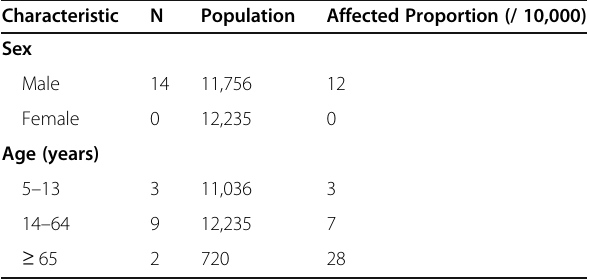
Table 1 Distribution of cutaneous anthrax case-persons by